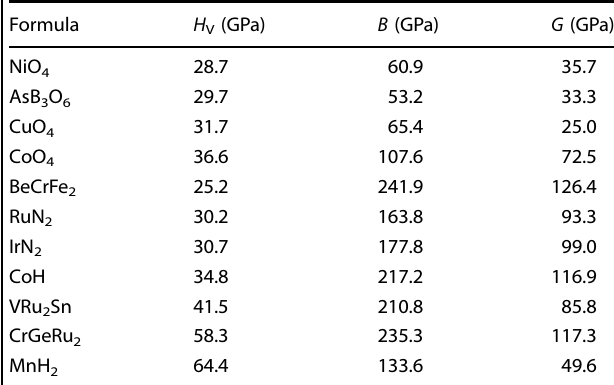
Table 2. Vicker ’ s Hardness ( H V ), as well as bulk ( B ) an shear ( G ) moduli of some hard and superhard